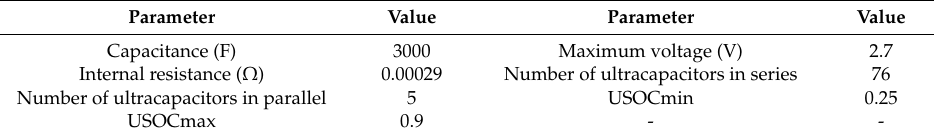
Table 7. Ultracapacitor parameters.